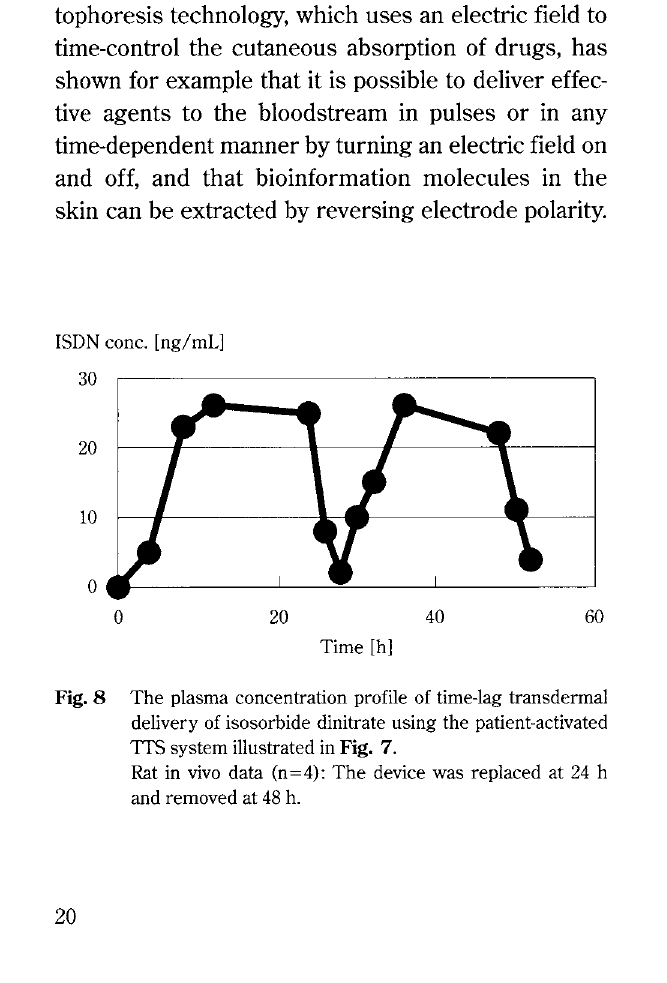
Time [h] The plasma concentration profile of time-lag transdermal delivery of isosorbide dinitrate using the patient-activated TTS system illustrated in Fig. 7. Rat in vivo data (n=4): The device was replaced at 24 h and removed at 48 h.